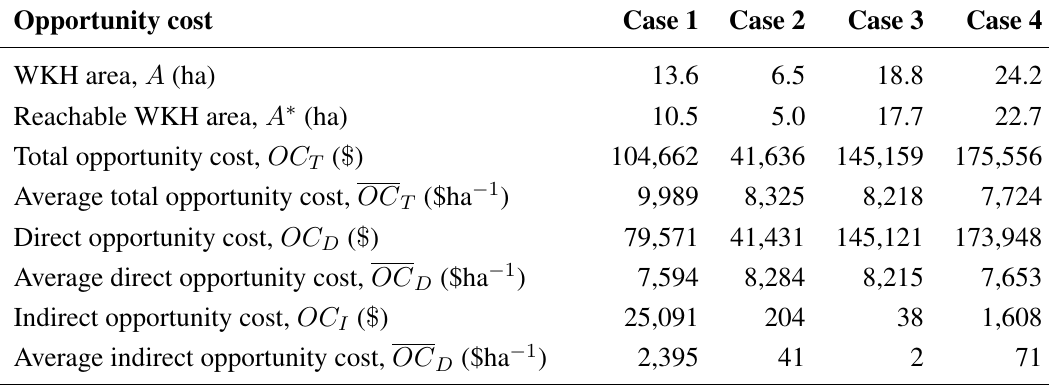
Table 4. Opportunity costs.